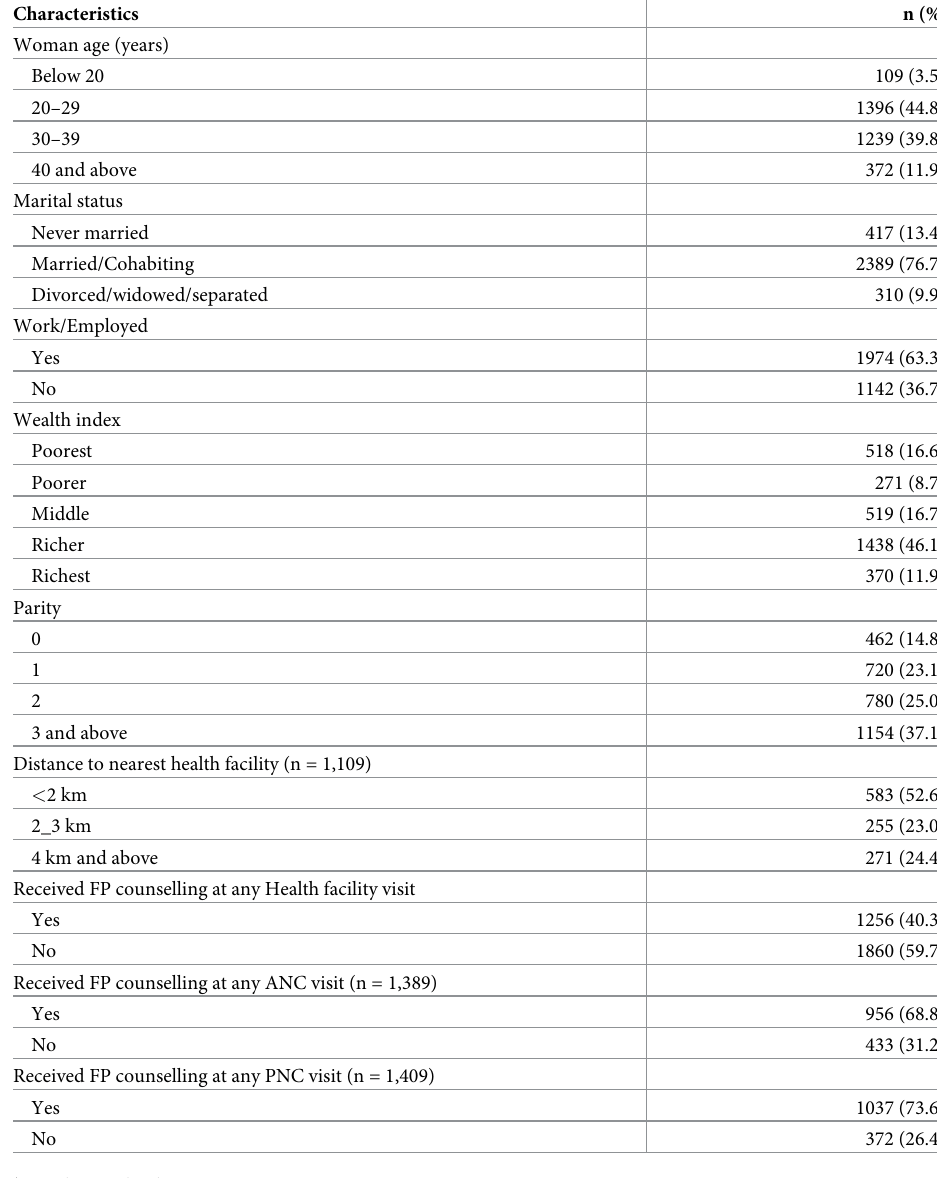
Table 1. Characteristics of the study participants (N =